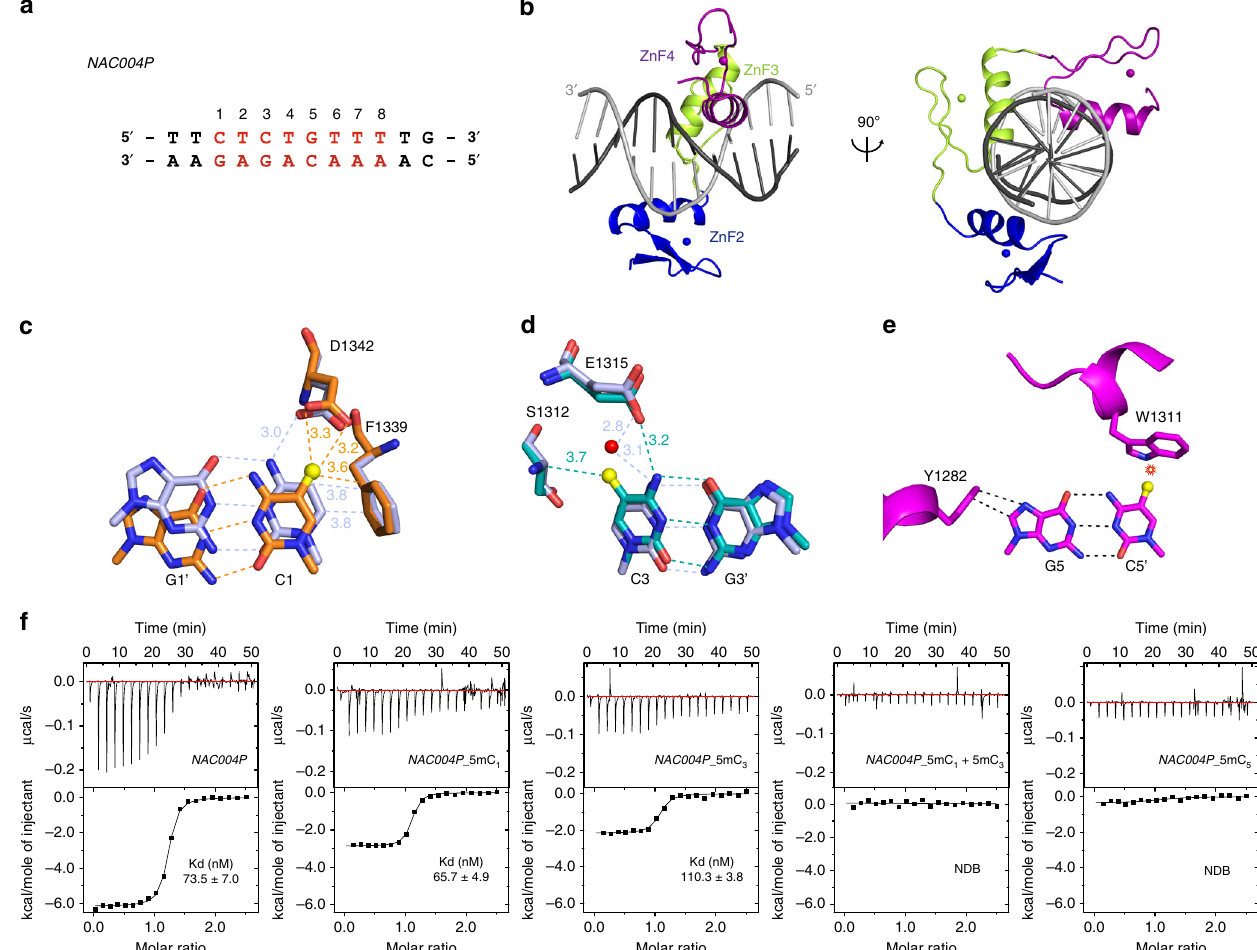
Fig. 4 Molecular basis of REF6 ZnF-clusters and unmethylated DNA. a DNA sequence used for crystal analysis and ITC assay. NAC004P is the partial of NAC004 probe. b Crystal structure of REF6 ZnF2-4 in complex with NAC004 dsDNA. Zinc fi nger domains are highlighted in blue (ZnF2), lime green (ZnF3), and purple (ZnF4). ZnF2-4 and DNA are shown as cartoon representations. The coding strand of DNA is shown in gray, and the non-coding strand in black. Spheres are Zn atoms. c Structural basis of the interaction of mC 1 with F1339 and D1342. F1339 engages in hydrophobic interactions with 5mC 1 and D1342 forms a weak C – H … O type of hydrogen bond with the 5mC methyl group. d Structural basis of interaction of mC 3 with S1312 and E1315. S1312 makes a weak C – H … O type of hydrogen bond with the 5mC methyl group and E1315 forms a direct H-bond with mC 3 . e Modeling a methyl group onto unmodi fi ed C 5 in the non-coding strand reveals potential steric hindrance (indicated by a red star) with W1311. f ITC assays showing decreased interaction between REF6-ZnFs and methylated DNA probes. NDB no detectable binding NATURE COMMUNICATIONS| (2019) 10:2063